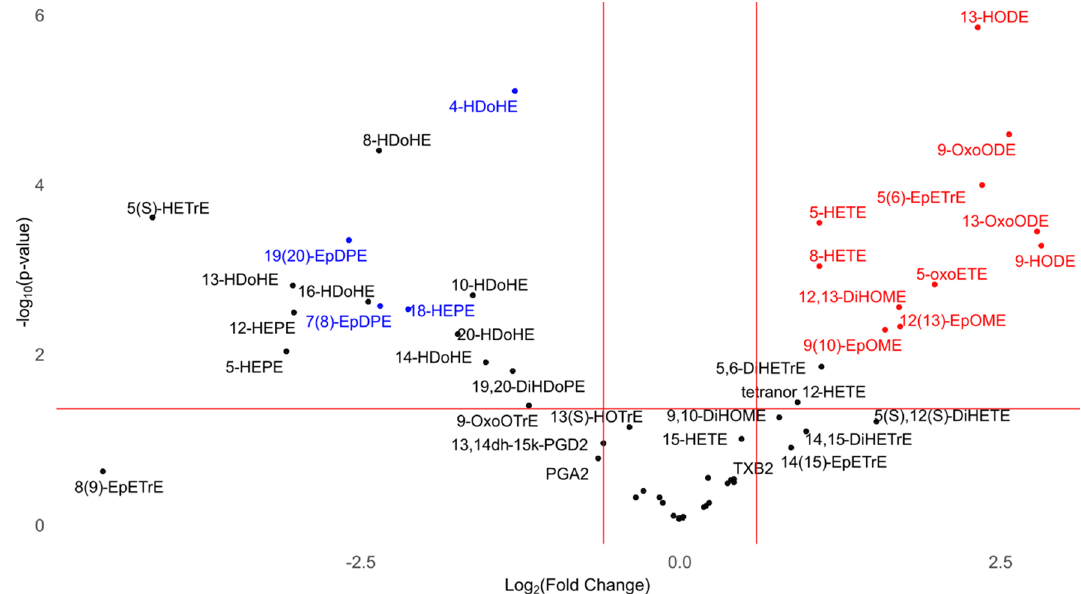
Figure 2. Excessive dietary linoleic acid promotes plasma accumulation of pronociceptive fatty acyl lipid mediators. Volcano plot of rat plasma LMs quantified after exposure to a diet rich in LA (n = 11) vs OA (n = 12). The X axis is the ratio, Log 2 (Fold Change), of the plasma LM concentration in animals fed an LA-rich diet/ plasma LM concentration in animals OA-rich diet. LMs with a positive Log 2 (Fold Change) were higher in concentration in the plasma of animals fed the LA-rich diet than in the plasma of animals fed the OA-rich diet. Conversely, LMs with a negative Log 2 (Fold Change) were higher in concentration in the plasma of animals fed the OA-rich diet than in the plasma of animals fed the LA-rich diet. The Y axis (− Log 10 p value) represents the significance of any differences. LMs with known pronociceptive activity are highlighted in red and those with known antinociceptive activity are highlighted in blue (See Table 1 footnote for the